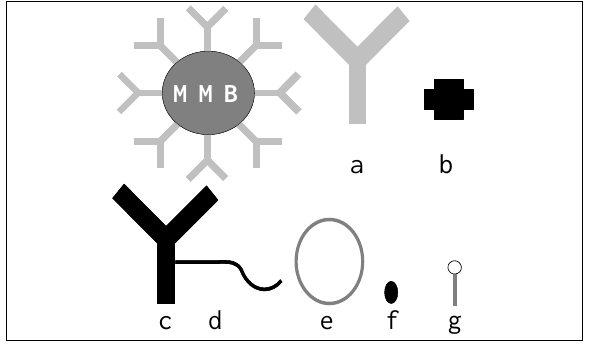
Figure 20. Components of rolling circle amplification on magnetic particle MMB Magnetic microparticle; a Polyclonal anti-human IgE antibody; b Human IgE; c Monoclonal anti-human IgE antibody; d Oligonucleotide linked to the antibody c; e Circular DNA; f Polymerase; g Labeled